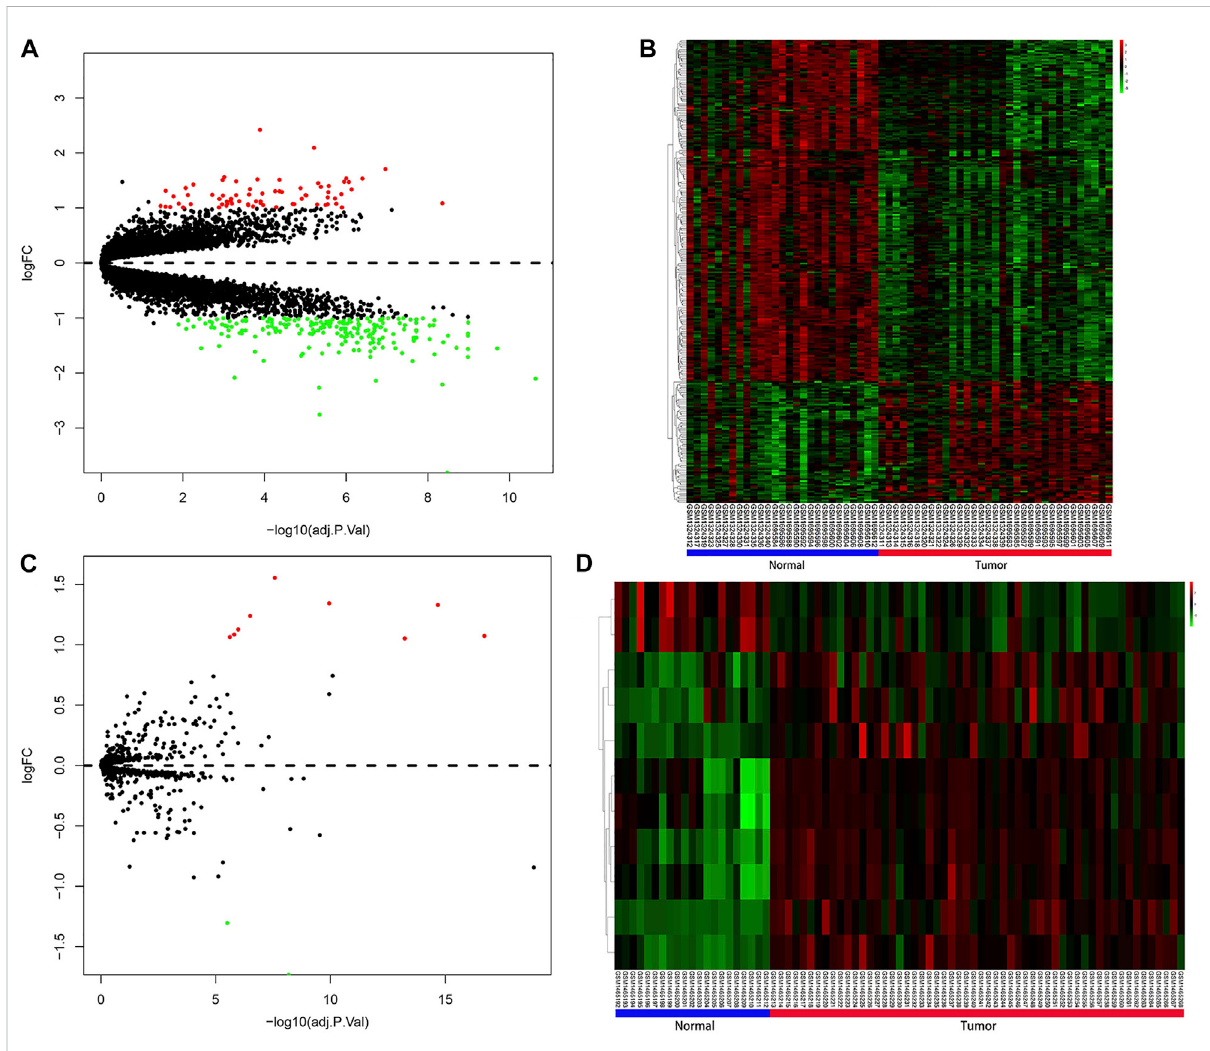
FIGURE 2 Results of differential expression analysis. (A) Volcano plot for DEGs. (B) Heatmap for DEGs. (C) Volcano plot for DEMs. (D) Heatmap for DEMs. Red indicated upregulated DEGs or DEMs, green indicated downregulated DEGs or DEMs, and black indicated genes or miRNAs that were not differentially expressed. In the heatmaps of DEGs and DEMs, the vertical axis represents genes or miRNAs that were clustered by similarity of their transcription pro fi le, and the horizontal axis represents samples. DEGs, differentially expressed genes; DEMs, differentially expressed